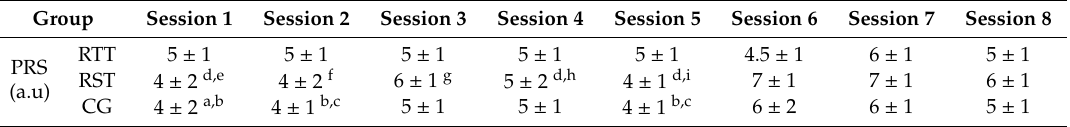
Table 2. Perceived recovery status scores recorded during the di ff erent training sessions (values are mean ± SD) for the RTT ( n = 12), RST ( n = 12) and CG ( n =